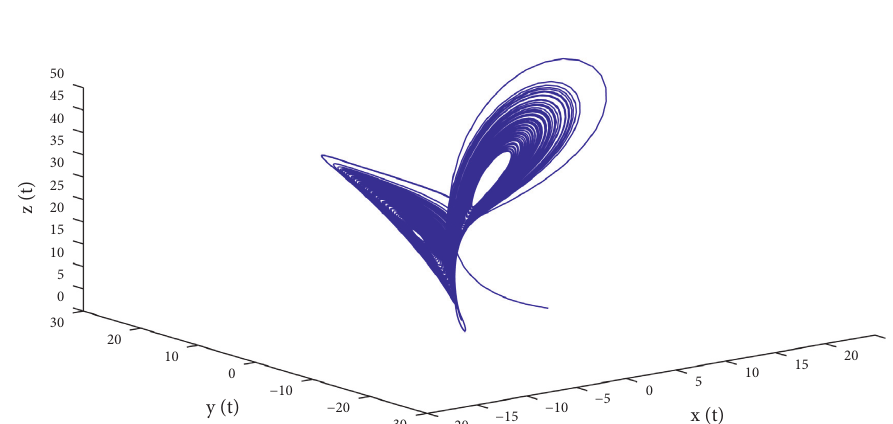
Figure 1: The attractor graph of the Lorenz chaotic map.